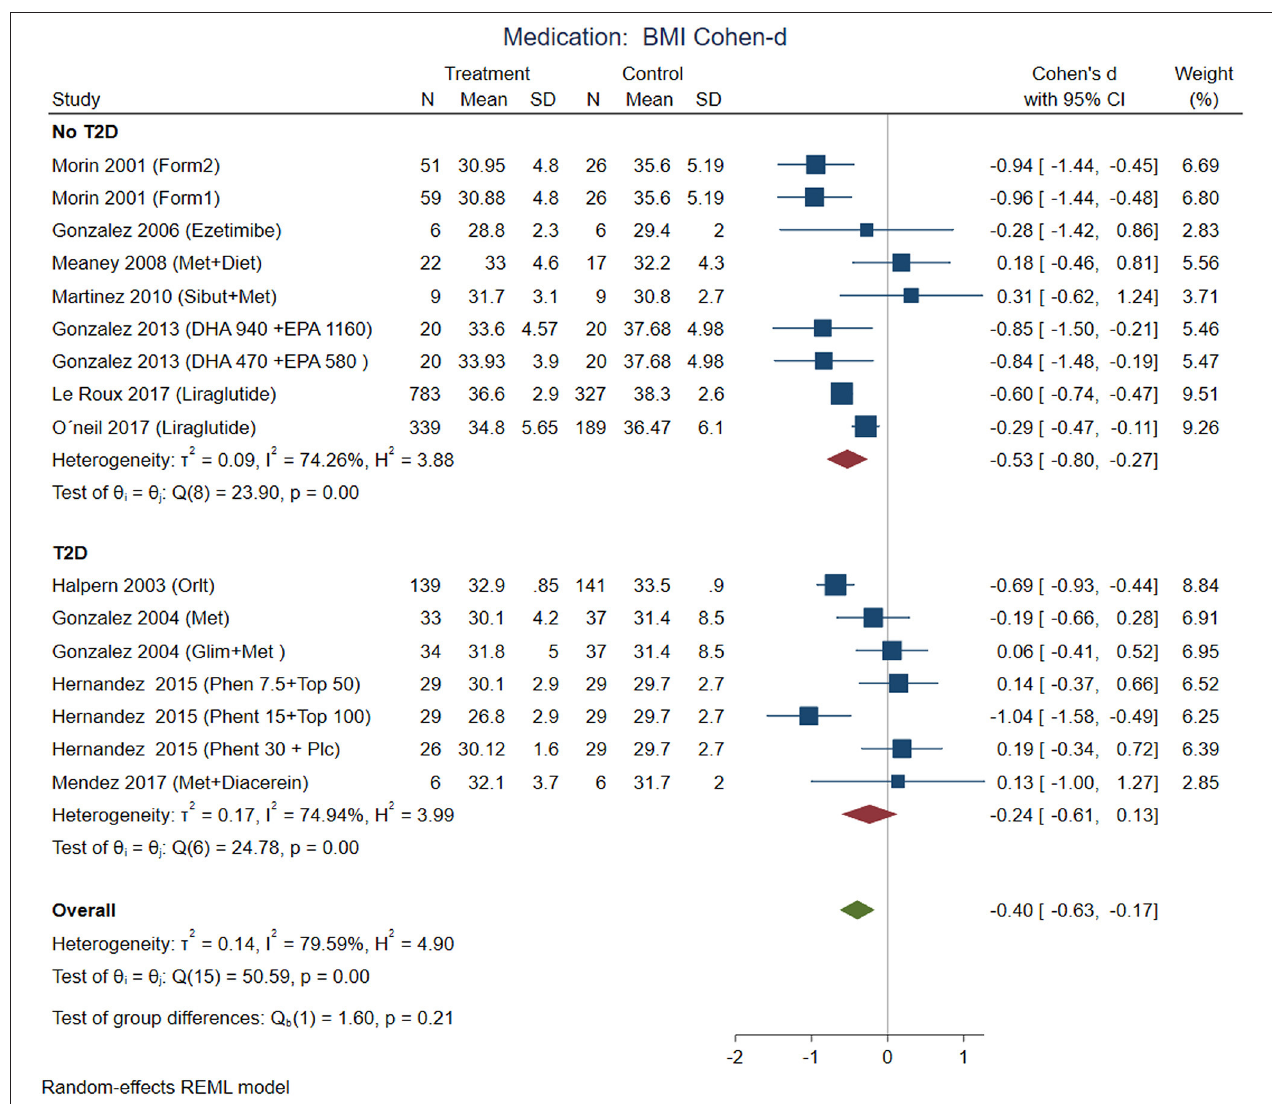
FIGURE 7 | Pooled analysis of Cohen’s d-weighted effect size on BMI reduction loss with drug (medication) treatment. The analysis was stratified by T2D status. The Form1 and Form2 are described in the text, they are not approved by FDA. Met, Metformin; Sibut, Sibutramine; DHA, Docosahexaenoic acid; EPA, Eicosapentaenoic acid; Orlit, Orlistat; Glim, Glimepiride; Phent, Phentermine; Top, Topiramate. REML, Restricted maximum likelihood.